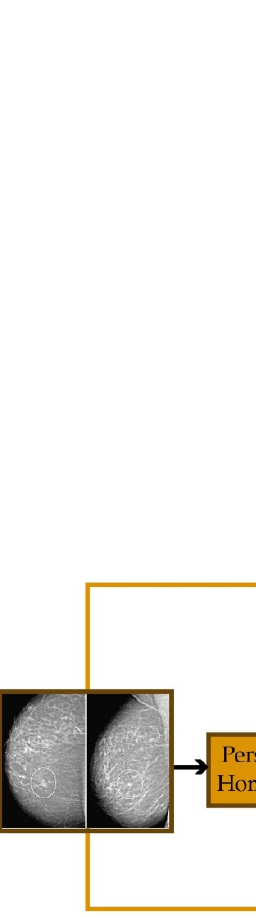
Figure 9. Predict genomic biomarkers—TP53 mutation model.